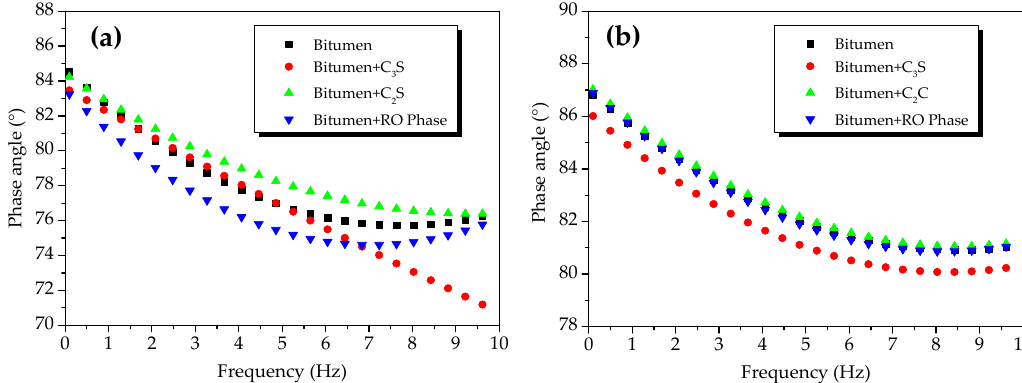
Figure 9. Phase angles of mixtures of modified bitumen and mineral components of steel slag (C 2 S, C 3 S, and RO) at different temperatures: ( a ) 45 ° C and ( b ) 55 ° C.